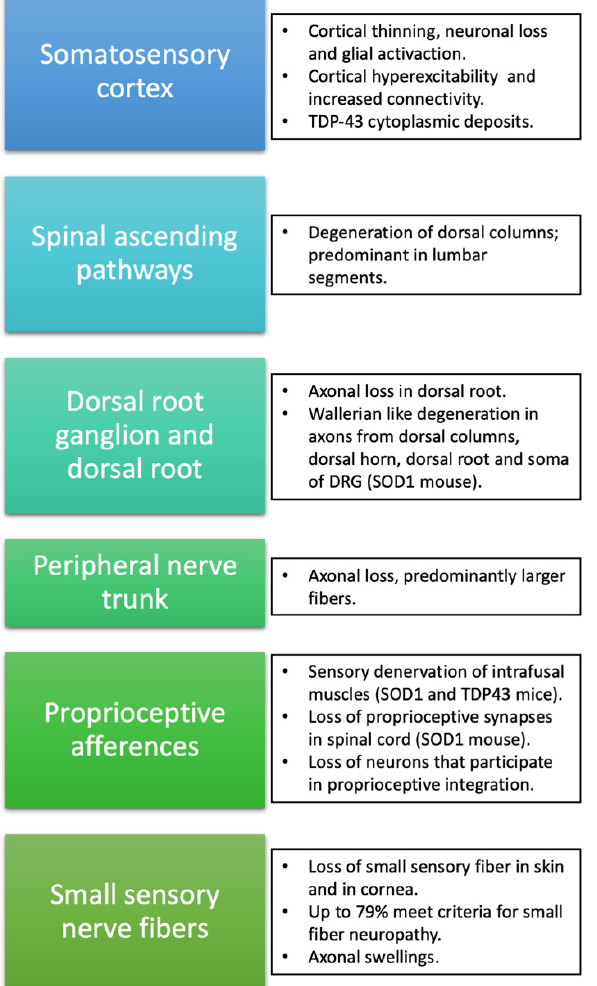
Figure 1. Schematic summary of alterations described in ALS at the different levels of the soma- tosensory